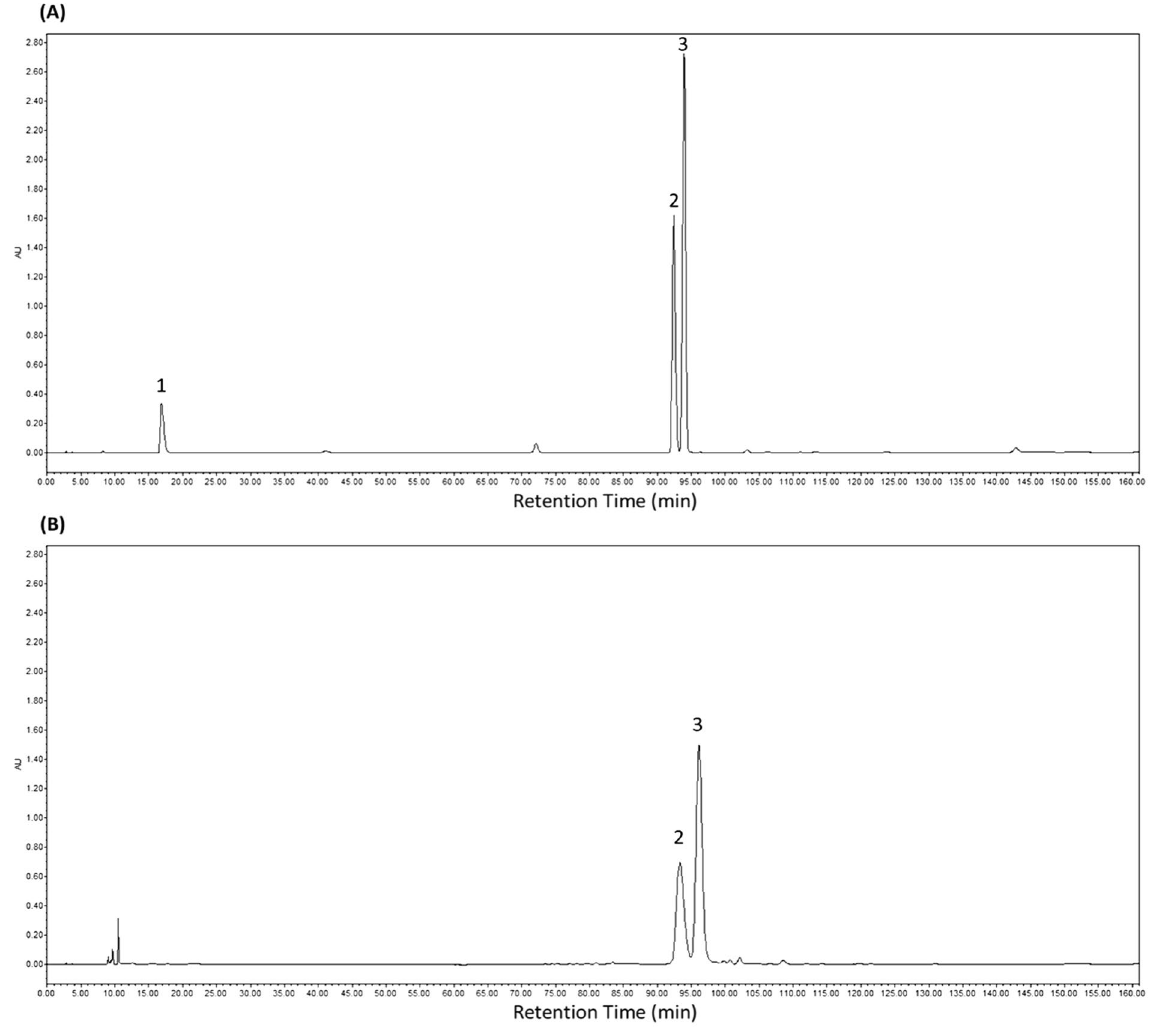
Figure 1. HPLC chromatograms of formononetin and isoliquiritigenin in TFSD. ( A ) Mixture of epicatechin, formononetin and isoliquiritigenin standards; ( B ) Analysis of formononetin and isoliquiritigenin in TFSD. Elution peaks: 1: epicatechin; 2: formononetin; 3: